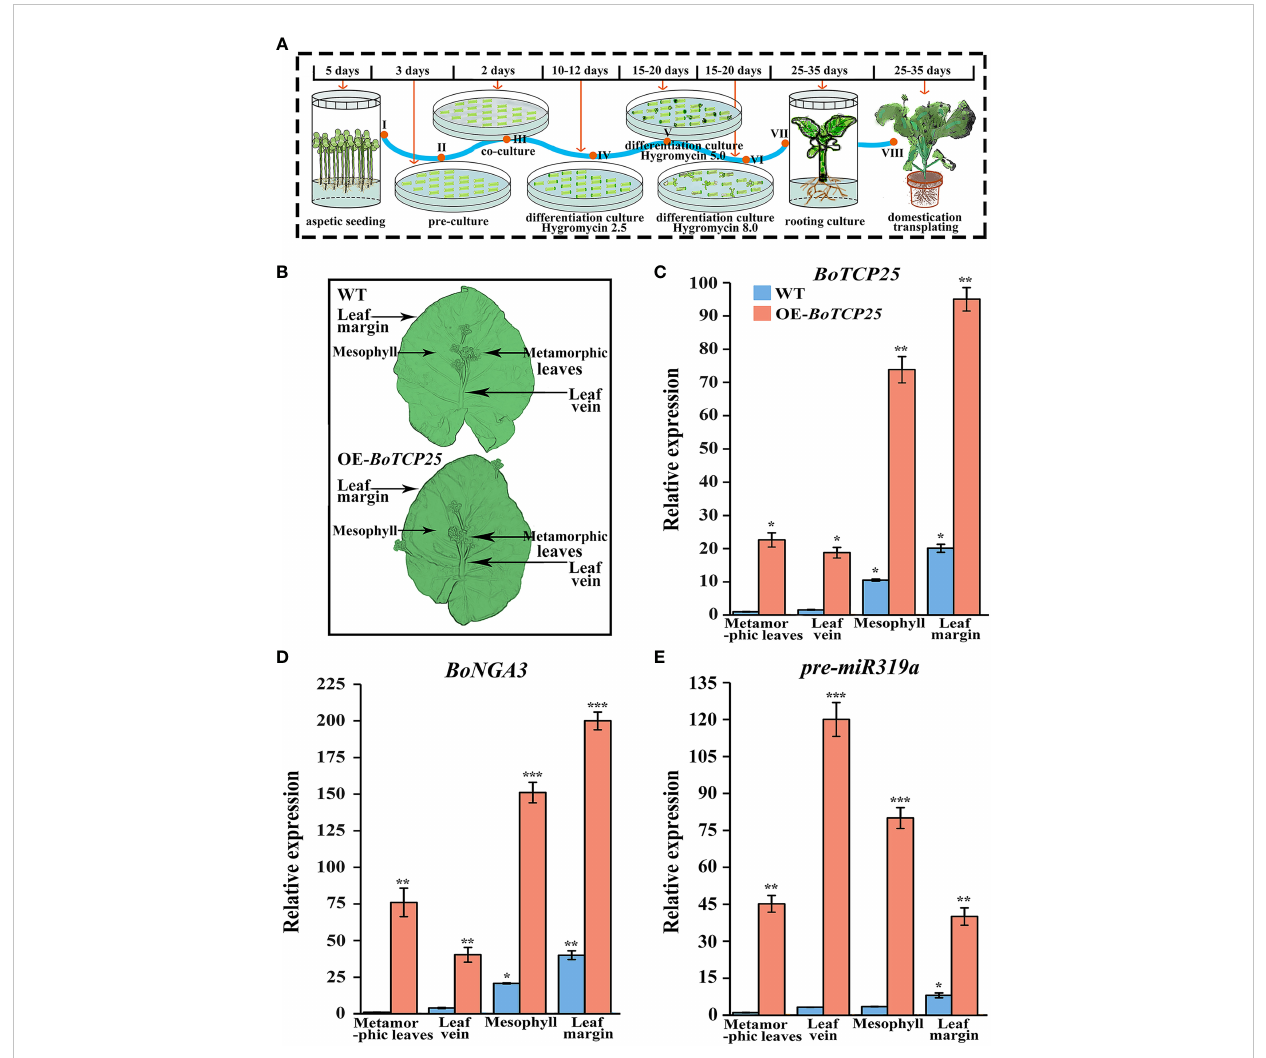
FIGURE 4 Identi fi cation of transgenic plants and gene expression of overexpressed BoTCP25-GFP XG plants. (A) Schematic diagram of genetic transformation of BoTCP25 to XG Chinese kale. (B) Diagram of sampling site of Chinese kale plant leaves. The expression of BoTCP25 (C) , BoNGA3 (D) , and pre- miR319a (E) in different parts of the XG leaf. Bars are equal to 100 mm. *p<0.05, **p<0.01, and